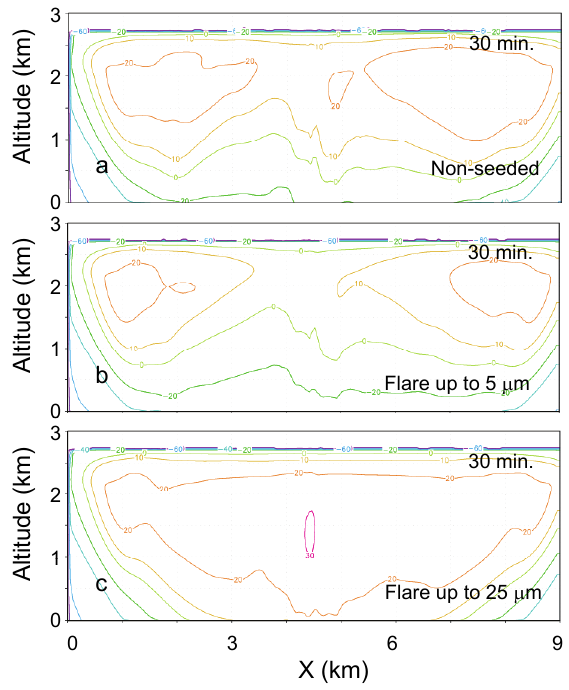
Fig. 17. Same as Fig. 16 except at